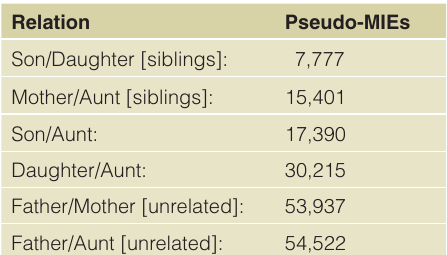
Table 4. Incompatible sites between remaining relationships, identified as pseudo-MIEs.